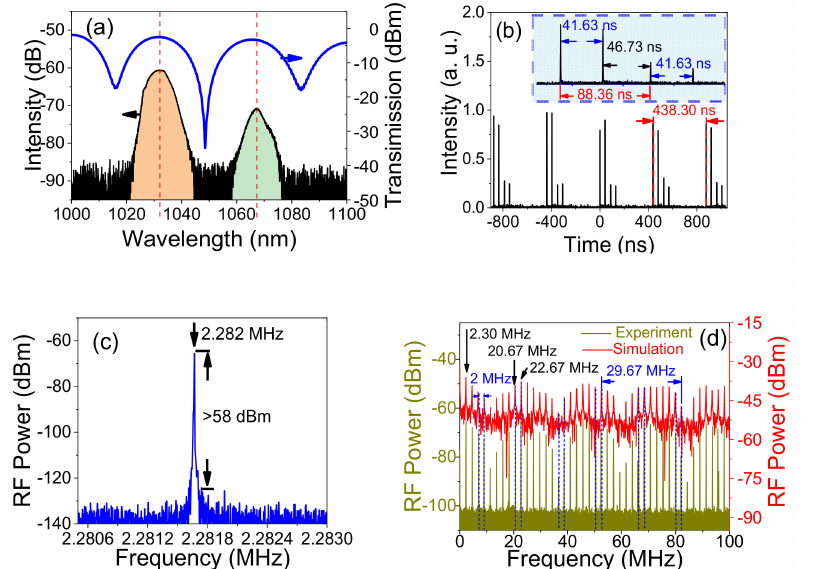
Figure 3. ( a ) Spectrum of the twin-pulse DSs and its comparison with the corresponding transmission spectrum of the Sagnac loop; ( b ) The mode-locked pulses train of the twin-pulse DSs; inset, the enlarge of the two twin-pluses DSs; ( c ) Radio-frequency spectrum of the two twin-pulse DSs with 2.5 KHz bandwidth; ( d ) Radio-frequency spectrum of the two twin-pulse DSs with 100 MHz bandwidth, measured by Radio-frequency analyzer (brown curve) and calculated from the pulse train measured by an oscilloscope (red